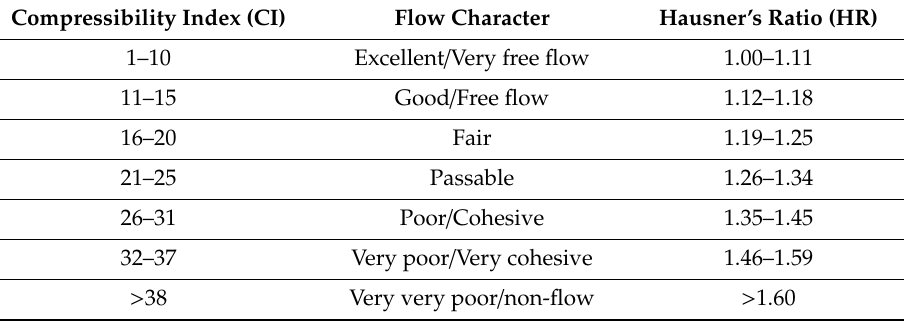
Table 1. Indication of flow character by the compressibility index and Hausner’s ratio